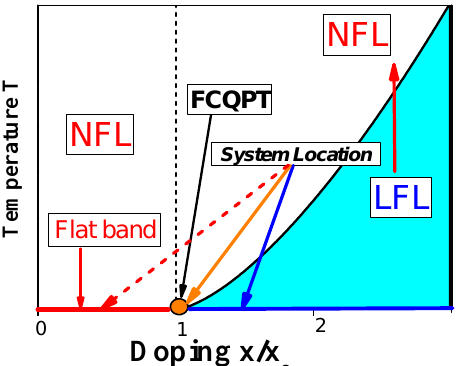
Figure 7. Schematic temperature T —doping x / x c phase diagrams of HF metals. The number density x is taken as the control parameter and depicted as x / x c . At x / x c < 1 the dashed arrow shows the the ordered phase of the topological FCQPT, when the system possesses flat bands. At any finite temperature T > 0 and at x / x c < 1, the system exhibits the NFL. The shadowed area corresponds to the case x / x c > 1 and sufficiently low temperatures, where the system is in the LFL